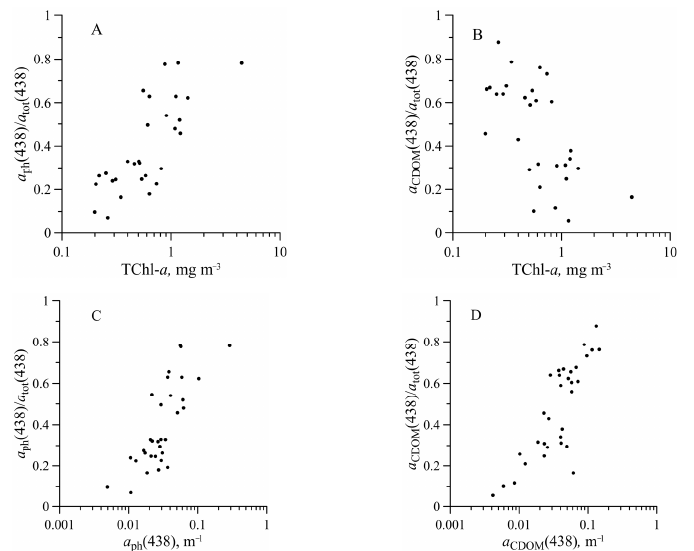
Figure 12. Relationship of the contribution of phytoplankton ( 𝑎 (cid:3043)(cid:3035) (438)/𝑎 (cid:3047)(cid:3042)(cid:3047) (438) ) ( A , C ) and col- oured dissolved organic matter ( 𝑎 (cid:3004)(cid:3005)(cid:3016)(cid:3014) (438)/𝑎 (cid:3047)(cid:3042)(cid:3047) (438) ) ( B , D ) to the total non-water absorption at 438 nm with the sum of chlorophyll a and phaeopigments concentration (TChl- a ) ( A,B ) and with a ph ( 438 ) ( C ) and with a CDOM ( 438 ) ( D )